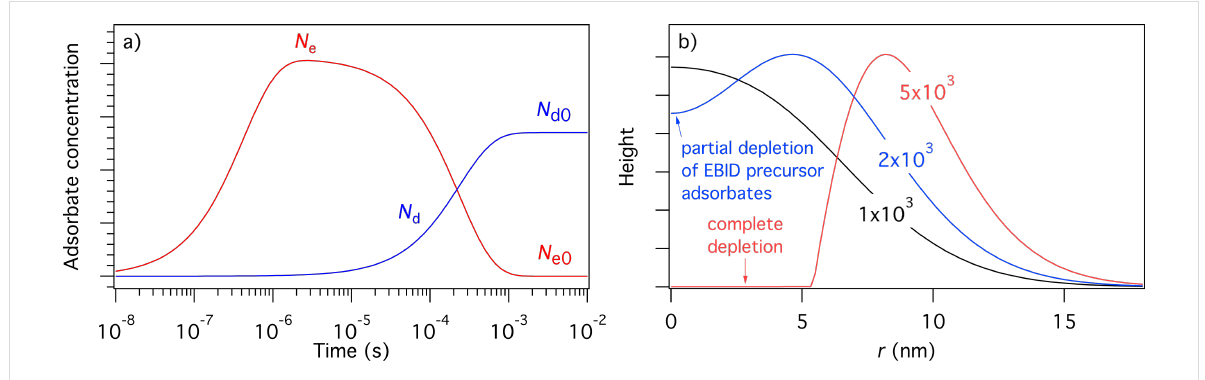
Figure 11: (a) Adsorbate concentrations N e and N d versus time, calculated in the absence of electron irradiation (here, N e = N d = 0 at t = 0). N e0 and N d0 are the steady-state adsorbate concentrations in the absence of electron irradiation, which are used as the initial adsorbate concentrations input into FEBIP models defined by Equation 27–Equation 37. (b) Deposit geometries simulated using a Gaussian electron beam with a standard deviation ( Ω ) of 5 nm and a maximum flux ( f 0 ) of 1 × 10 3 , 2 × 10 3 and 5 × 10 3 Å − 2 s − 1 . (Etch species = H 2 O, deposition species = C 10 H 22 , P e = 1 Torr, P d = 0.01 Torr, s e = 1, s d = 0.4, E e = 0.56 eV, E d = 1.0157 eV, κ e = κ d = 10 16 s − 1 , σ ε = σ δ = 1 Å 2 , σ r = σ rD = A d = 74 Å 2 , T = T g = 300 K. All other model input parameters were the same as in [11].)